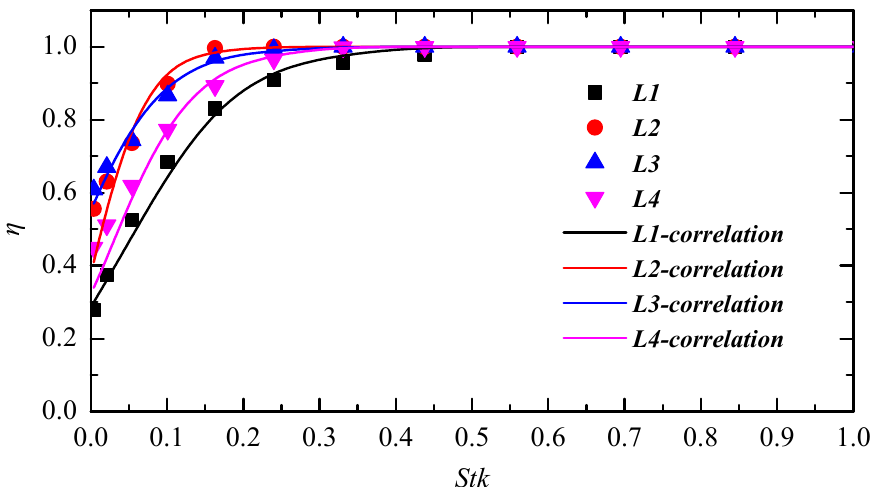
Figure 16. Numerical results of separation efficiency versus Stk number with different wavelength.